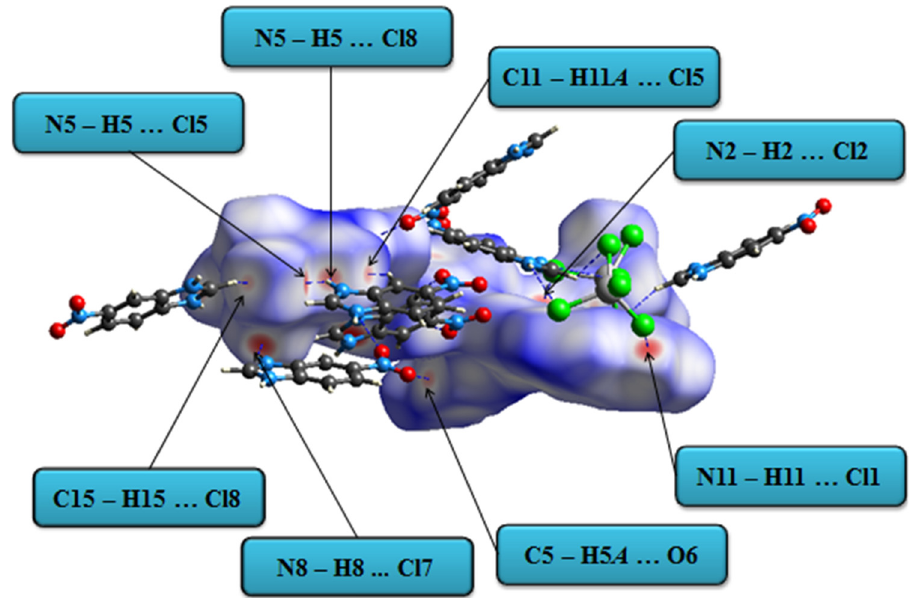
Figure 4. ( a ) Curvedness surface, ( b ) patch fragment surface, ( c ) d norm surface, ( d ) shape index sur-